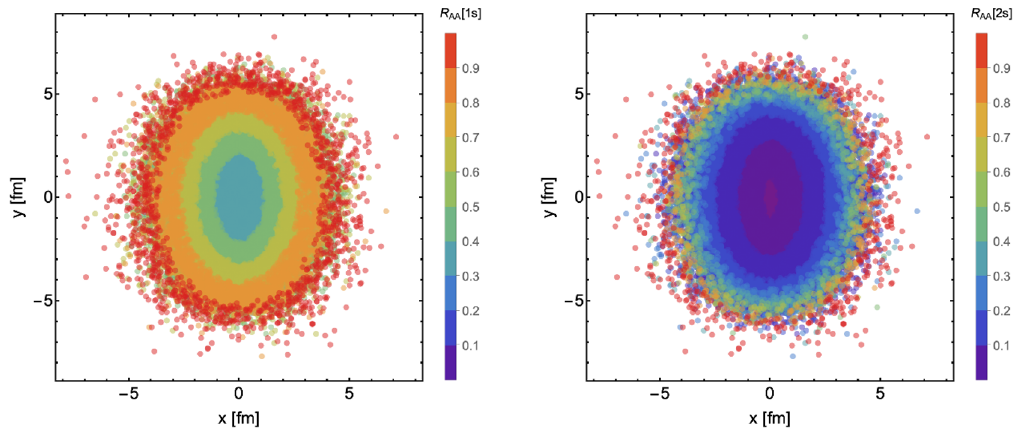
Figure 3 . Visualization of the starting positions of Υ(1 s ) (left) and Υ(2 s ) states (right). In both cases we selected all states with 0 < p